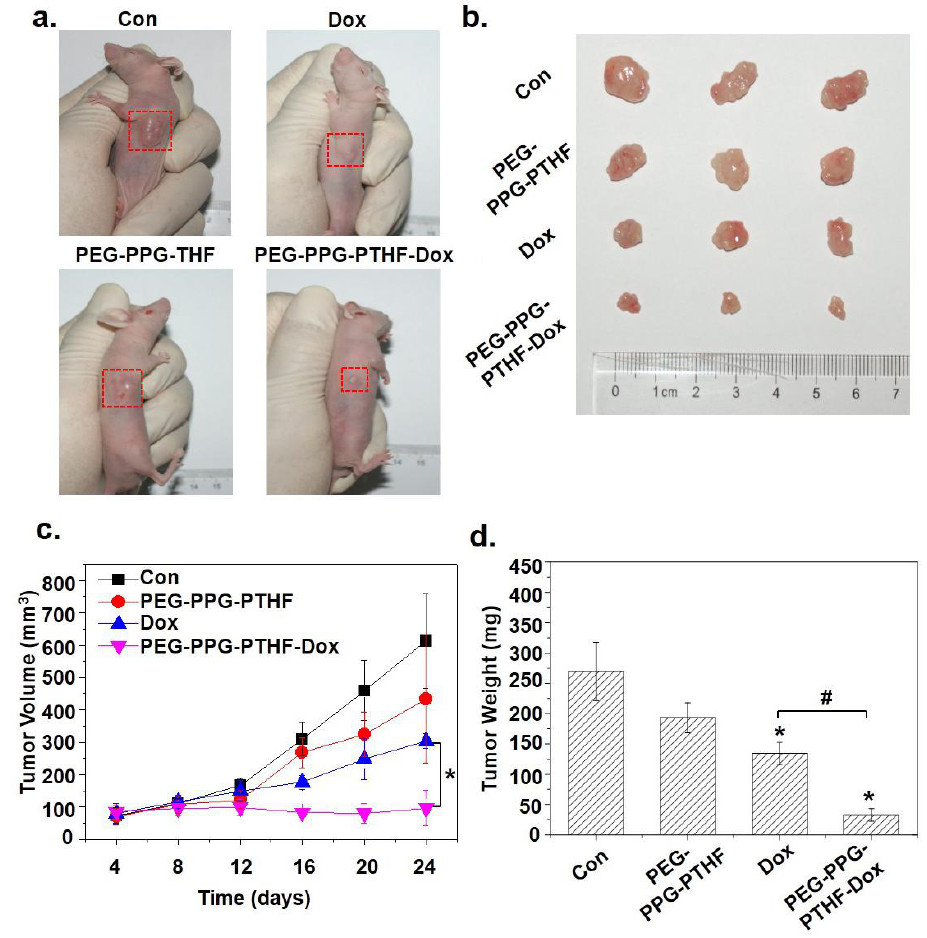
Figure 10. In vivo study of the Dox-loaded P2 thermogel. ( a ) Subcutaneous tumour sizes were recorded after the treatment with Dox-loaded P2 thermogel (PEG-PPG-PTHF-Dox), pristine P2 thermogel (PEG-PPG-PTHF) or Dox-only (Dox) for 16 days. ( b ) Images of respective tumours after being excised from the mice. ( c ) Tumour volumes were recorded every four days, the results were calculated using the equation: V (cm 3 ) = [length (cm) × width 2 (cm 2 )]/2. ( d ) After 16 days of treatment, the excised tumours were weighed. The data is presented in the form of mean ± standard deviations ( n = 3). # p < 0.05, with compared with Dox-only treatment; * p < 0.05, with compared with saline control treatment.